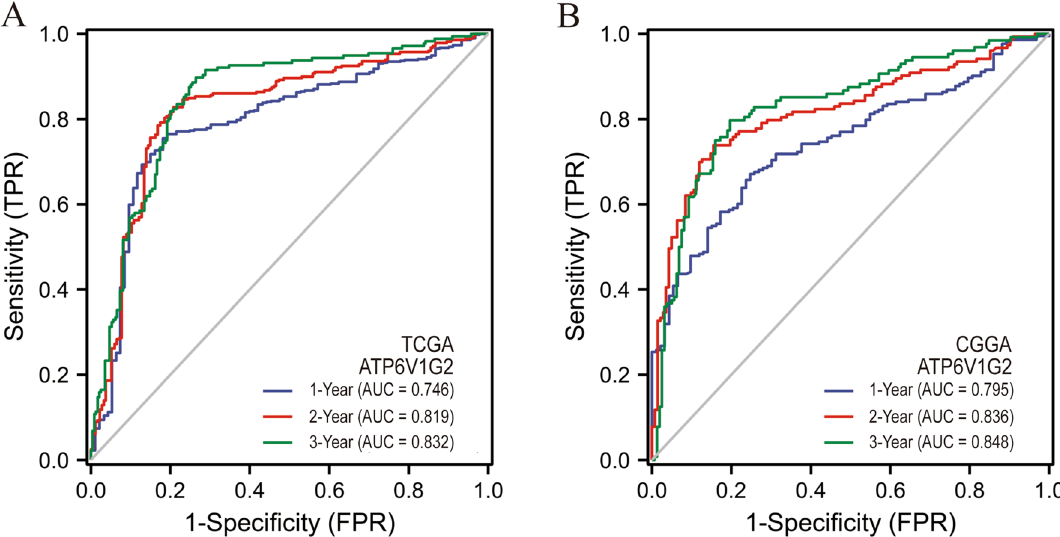
Figure 9. Validation of the ATP6V1G2 prognostic value. ( A ) The time-dependent ROC curve of ATP6V1G2 in TCGA database. ( B ) The time-dependent ROC curve of ATP6V1G2 in CGGA